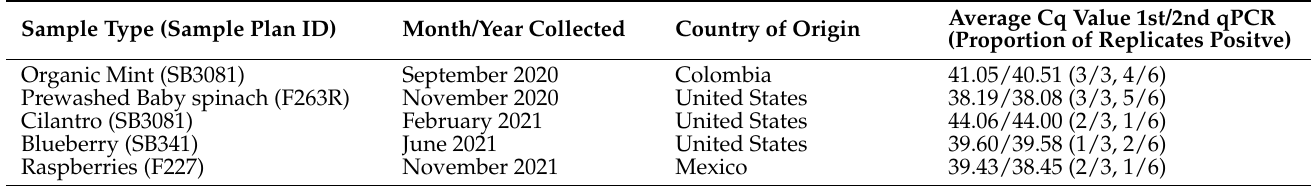
Table 8. Summary of information on the samples positive for Cyclospora